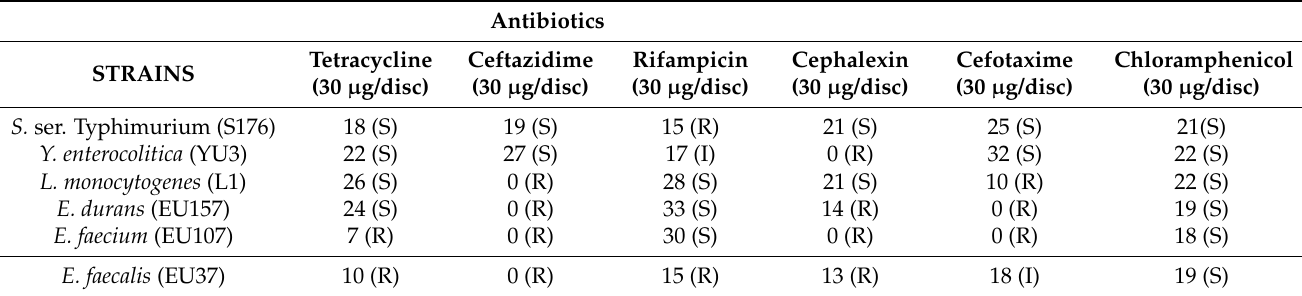
Table 2. The inhibition zones expressed in millimeters resulted from the application of different antibiotics against the selected bacterial strains (S: susceptible; R: resistant; I: intermediate).